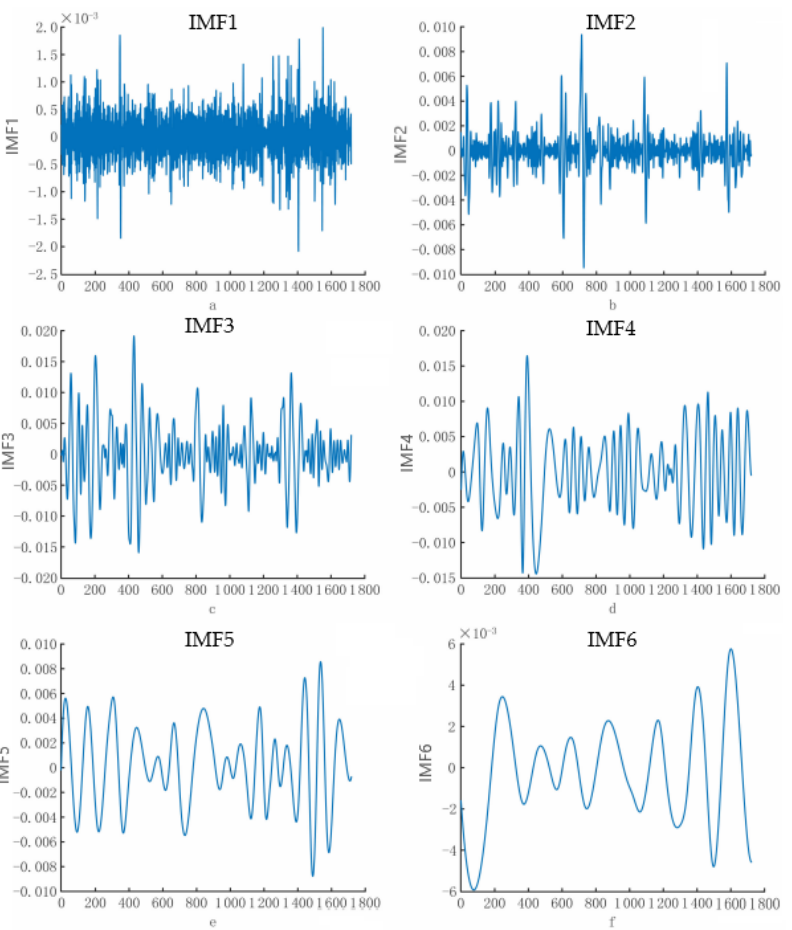
Figure 9. Image of fault data after EEMD decomposition. ( a ) IMF1 component after EEMD de- composition of fault data; ( b ) IMF2 component after EEMD decomposition of fault data; ( c ) IMF3 component after EEMD decomposition of fault data; ( d ) IMF4 component after EEMD decomposi- tion of fault data; ( e ) IMF5 component after EEMD decomposition of fault data; and ( f ) IMF6 component (residual component) after EEMD decomposition of fault data.